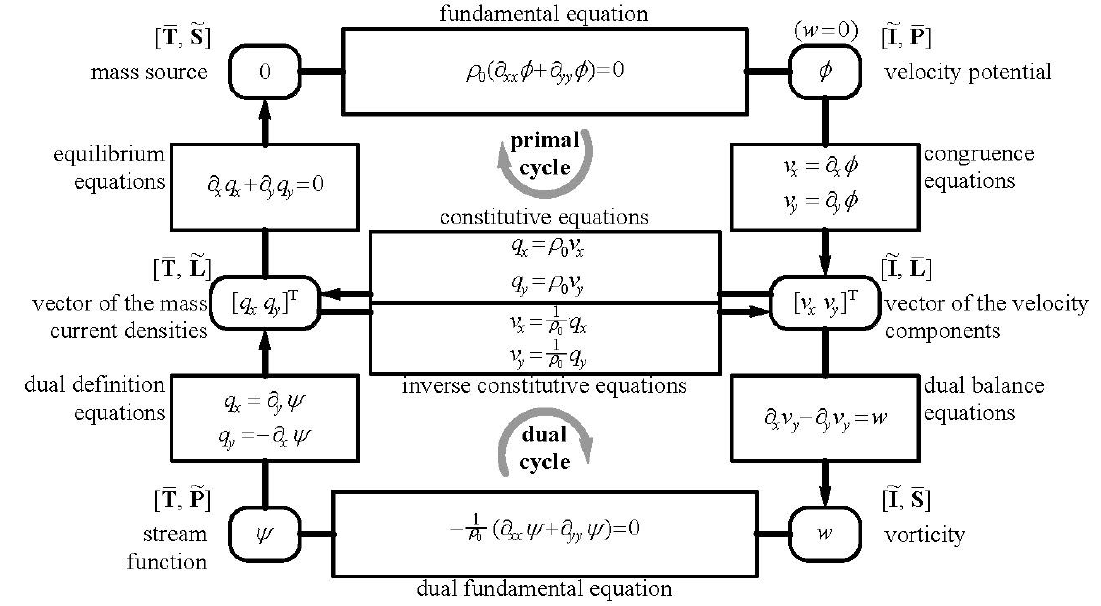
Figure 30: Classification diagram for the plane motion of a perfect, incompressible fluid.